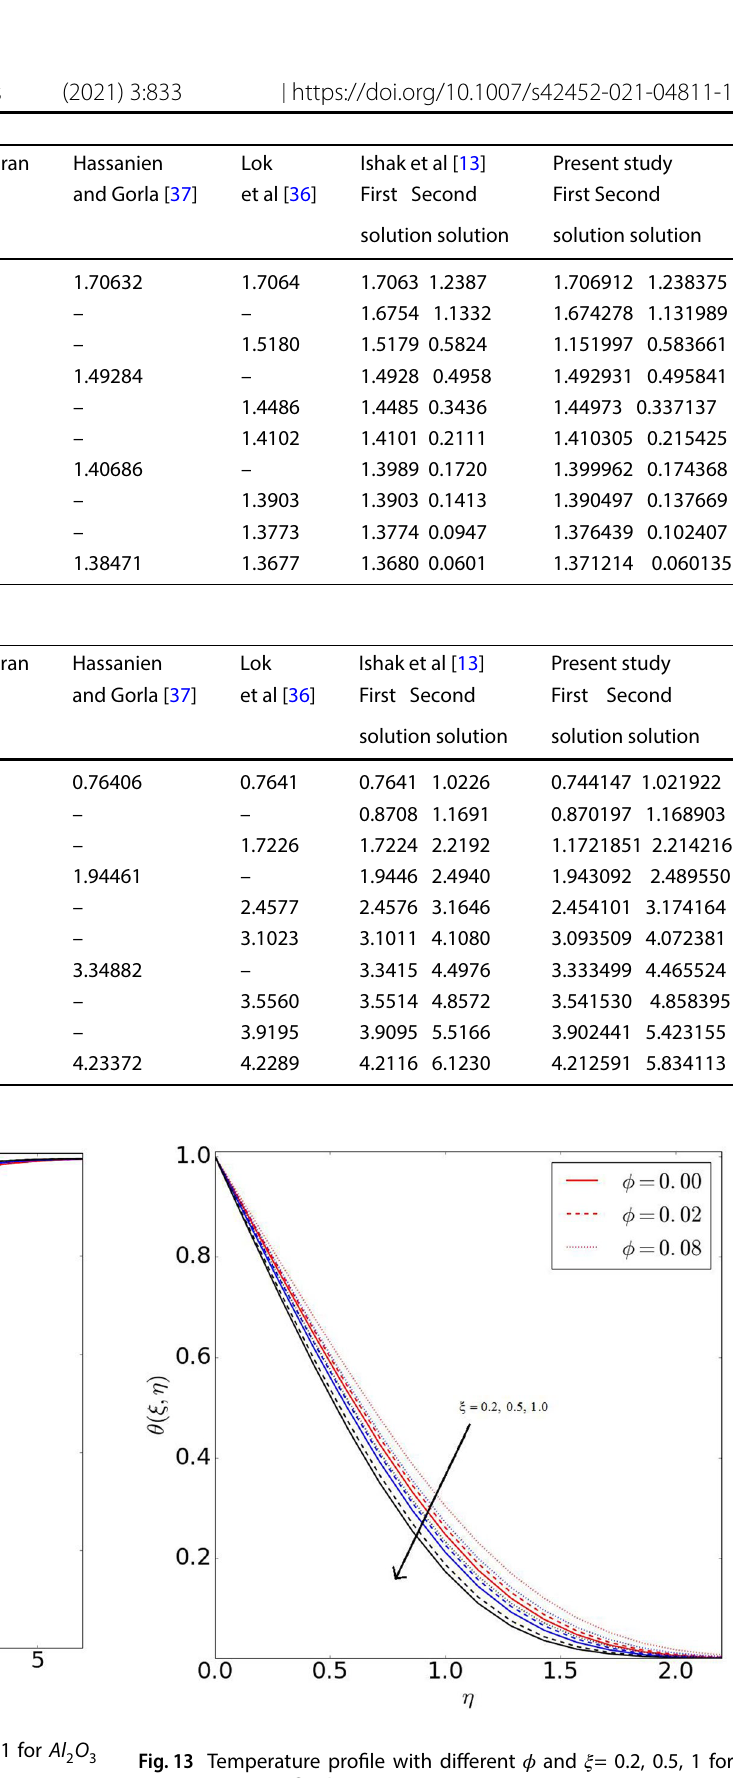
Fig. 13 Temperature profile with different 𝜙 and 𝜉 = 0.2, 0.5, 1 for